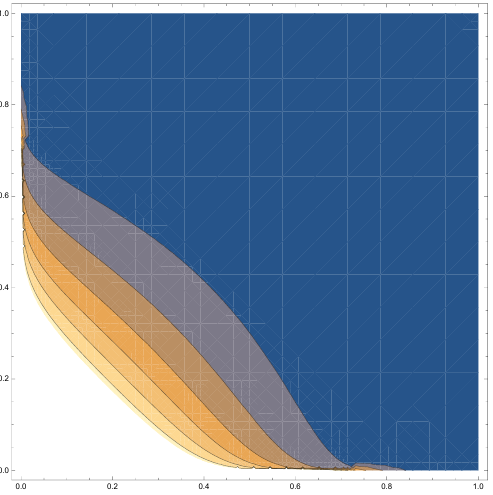
Figure A6. The bivariate Kumaraswamy contour (Equation (1)) plot, where α = 0.8, β = 0.8, θ = 0.4 and δ =